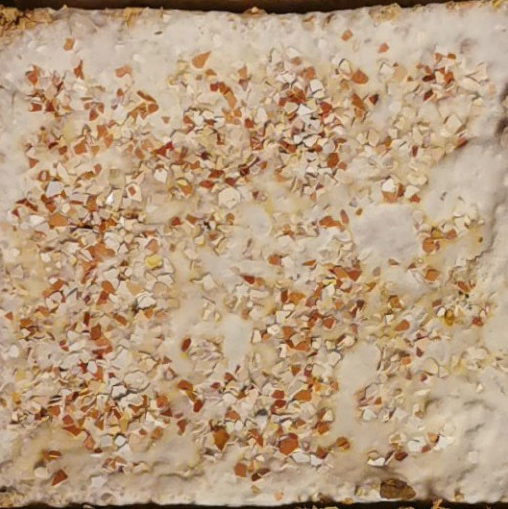
Figure 4. Sample based on hemp mix with eggshell. Surface: smooth with eggshell. Color: off-white mycelium, gray, eggshells (photo A. Bonenberg).